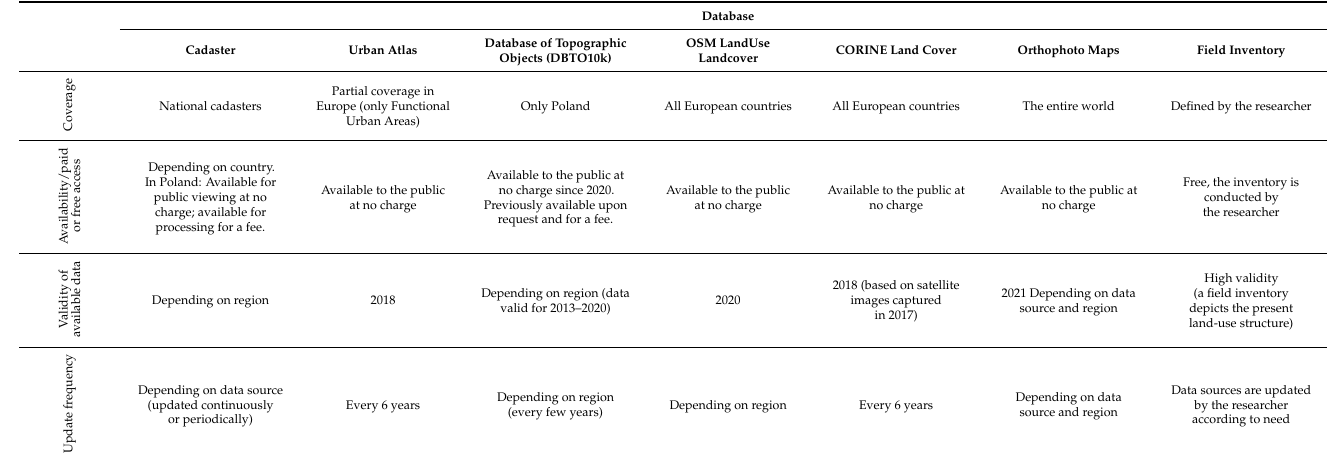
Table 3. Description of spatial data